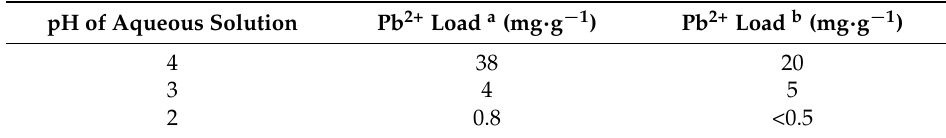
Table 4. Influence of aqueous solution pH on Pb 2+ uptake.